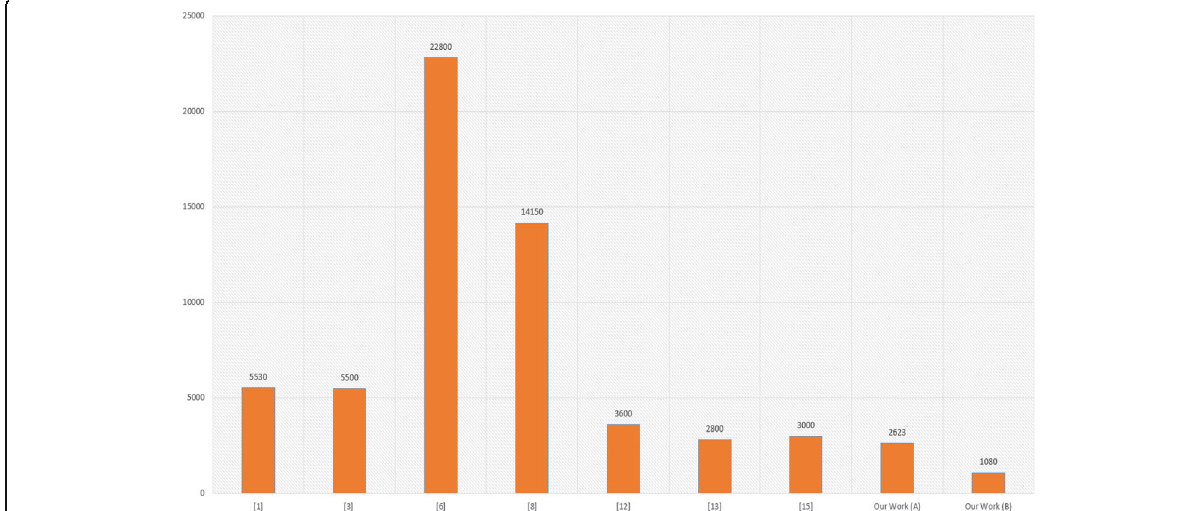
Fig. 5 128-bit encrypted key generation performance